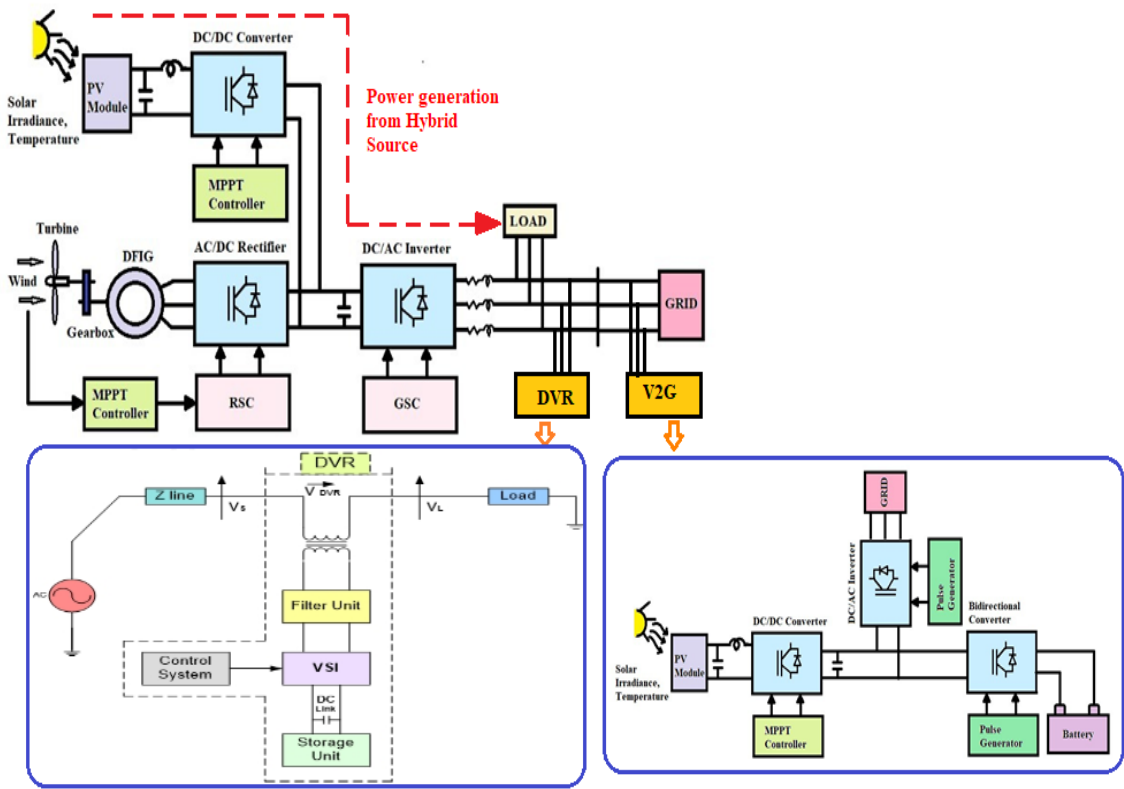
Figure 16. Normal Figure 16. Normal mode.